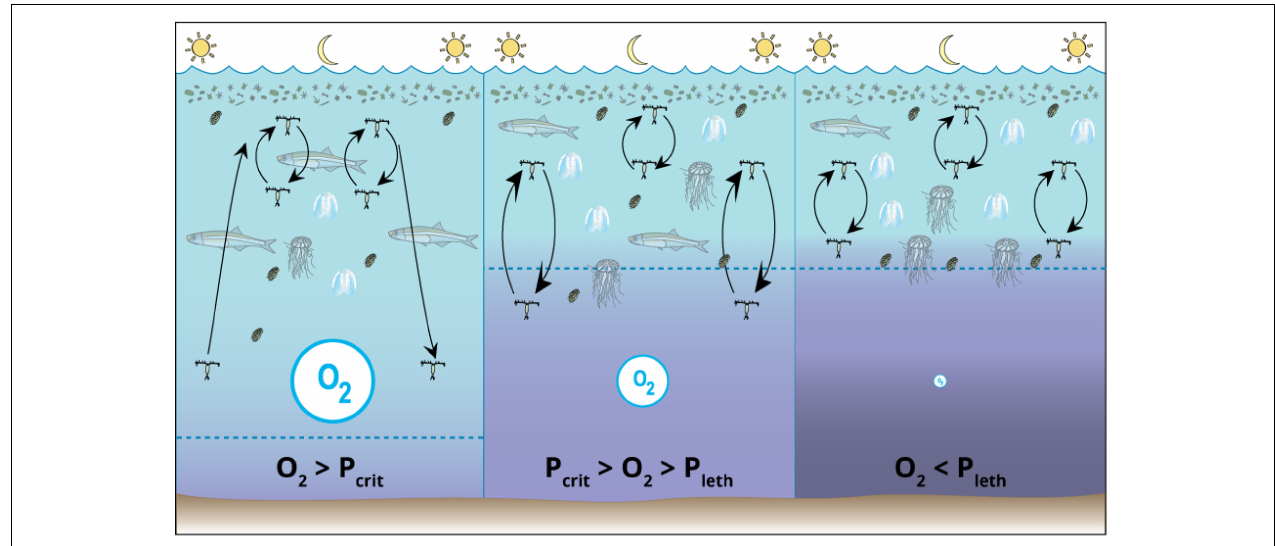
FIGURE 9 | Conceptual diagram of food web changes that may occur over diel cycles between normoxic conditions (left) , sub-lethal deoxygenation conditions (middle) , and lethal conditions (right) . The size of the symbol for O 2 and the color indicates the relative amount of dissolved oxygen under each condition (with light blue indicating high oxygen concentration and purple indicating lower oxygen concentration). With decreasing oxygen concentration comes reduced habitat, truncated magnitude of copepod vertical migration (shown by length of arrows), increased gelatinous zooplankton abundance, and decreased forage fish abundance. Symbols Courtesy of the Integration and Application Network, University of Maryland Center for Environmental Science (ian.umces.edu/symbols/).